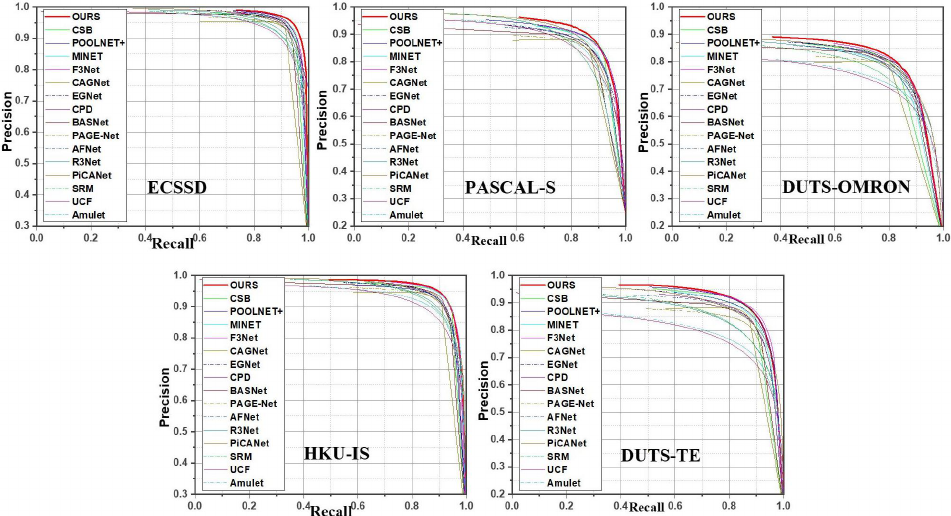
Figure 6. PR curve comparison on five different